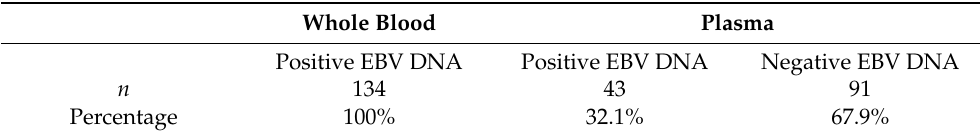
Table 2. Number of EBV DNA detection results in the plasma ( n = 134) versus the corresponding whole-blood ( n = 134) samples.